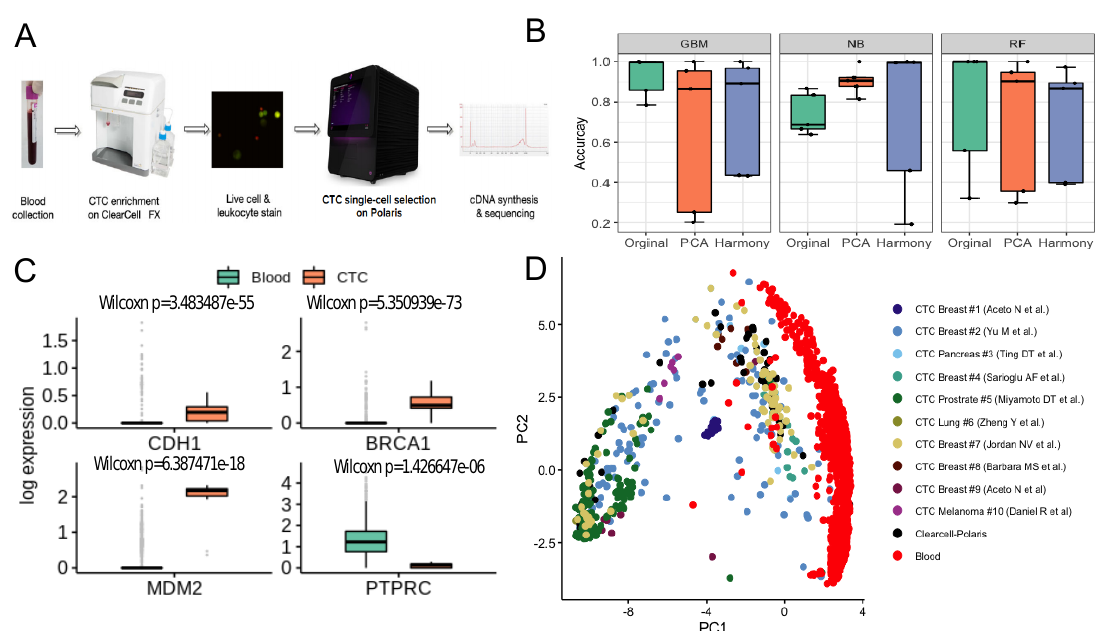
Figure 4. Label-free detection and characterisation of CTCs. ( A ) ClearCell-Polaris workflow involving size-based CTC enrichment by ClearCell FX system, followed by single cell selection and CD45/CD31 depletion using Polaris. ( B ) Performance of various machine learning algorithms in distinguishing between CTCs and PBMCs. Cells in each dataset were tested against a classifier trained on the remaining datasets. Box plots show the prediction accuracy’s for different choices of classification algorithms (Naive Bayes or NB, Random Forest or RF, Gradient Boosting Machine or GBM) and normalisation/batch-effect correction methods. ( C ) Box-plots showing canonical epithelial/breast cancer specific markers, up-regulated in the CTC population compared to the PBMCs. As expected, PTPRC, a pan leukocyte maker shows elevated expression levels in PBMCs as compared to CTCs. ( D ) Reference Component Analysis (RCA) based 2D projection of CTCs. PBMCs (red) are visibly separated from CTCs. CTCs enriched using the ClearCell-Polaris workflow cluster with CTCs of other